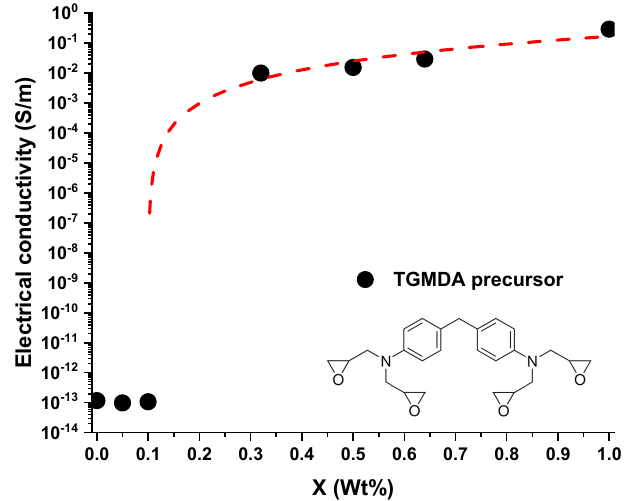
Figure 2. DC volume electrical conductivity (s) of the TGMDA-based formulation versus MWCNT weight percentage.